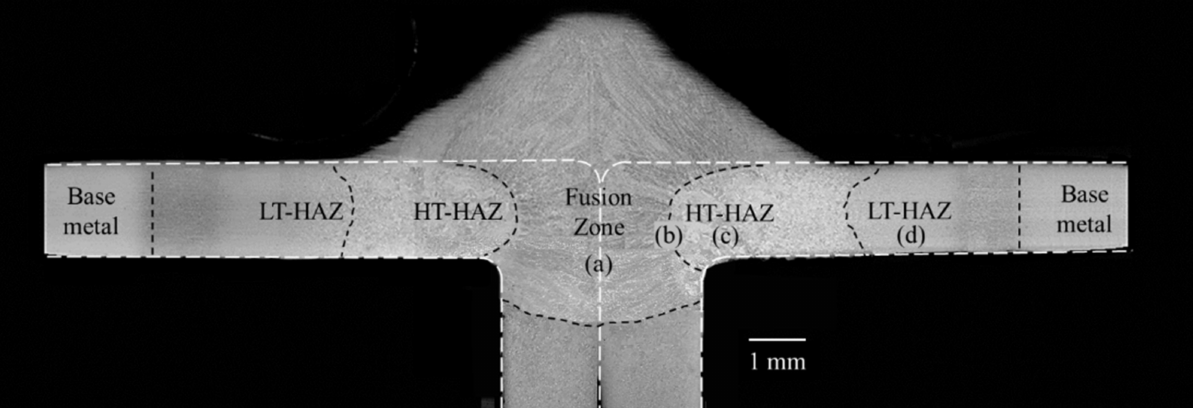
Figure 4. Transversal macrographic view of the GMAW joint. Complete welding penetration in the FZ is observed. The different welding zones are marked in the view. ( a ) Fusion zone, ( b ) fusion line, ( c ) high temperature heat affected zone and ( d ) low-temperature heat affected zone.